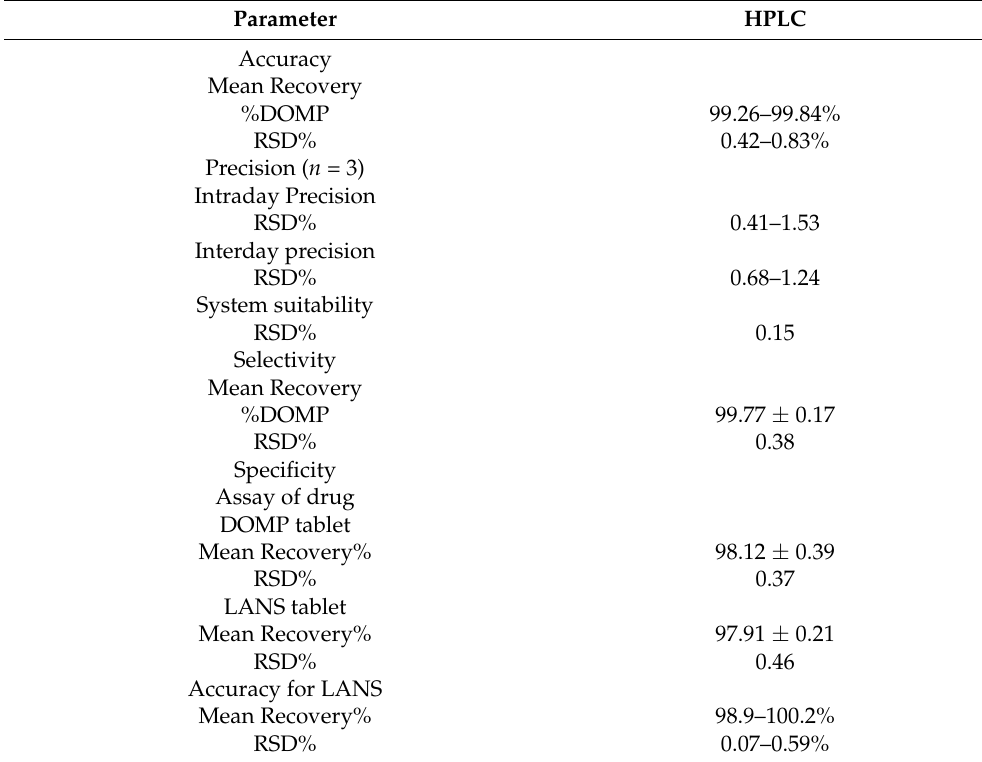
Table 3. Summary of validation parameters for the proposed HPLC